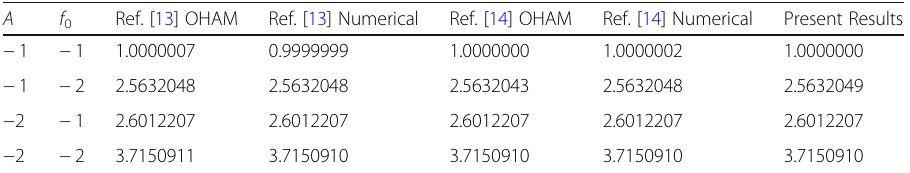
Table 1 Comparison of − f ′′ (0) for various values of A and f 0 given that Pr = 0.7, U 0 = − 1, N R = 0 A f 0 Ref. [13] OHAM Ref. [13] Numerical Ref. [14] OHAM Ref. [14] Numerical Present Results − 1 −